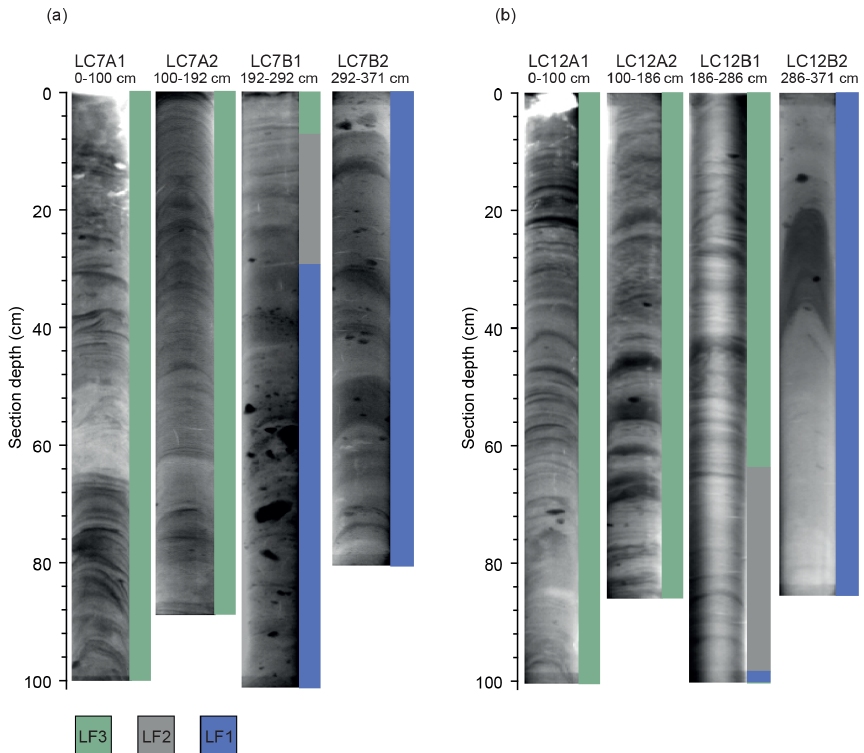
Figure 6. X-radiographs of (a) LC7 and (b) LC12 along with the associated lithofacies (LF)